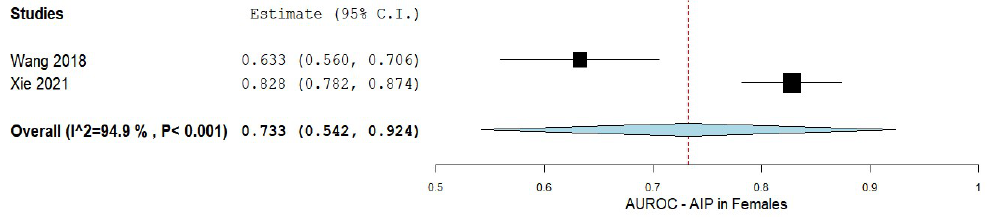
Figure 6. The accuracy of AIP in predicting NAFLD in females. AIP—Atherogenic index of plasma; NAFLD—Non-alcoholic fatty liver disease.